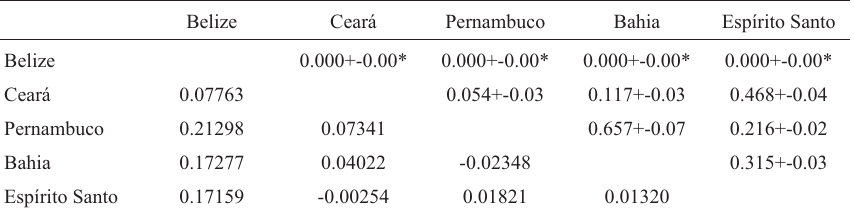
Table 5 - Pairwise mtDNA F ST values between O. chrysurus populations (below the diagonal). The significance of each value (H o : F ST = 0) is shown above the diagonal. * p < 0,05.